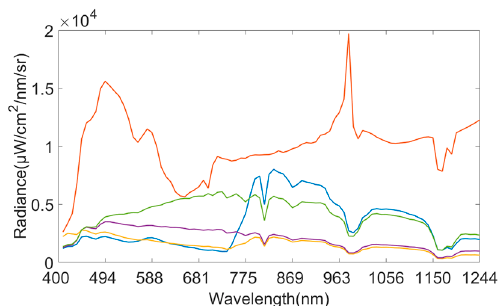
Figure 4. The five extracted spectra for the synthetic hyperspectral (HS) image simulation (first 90 bands).